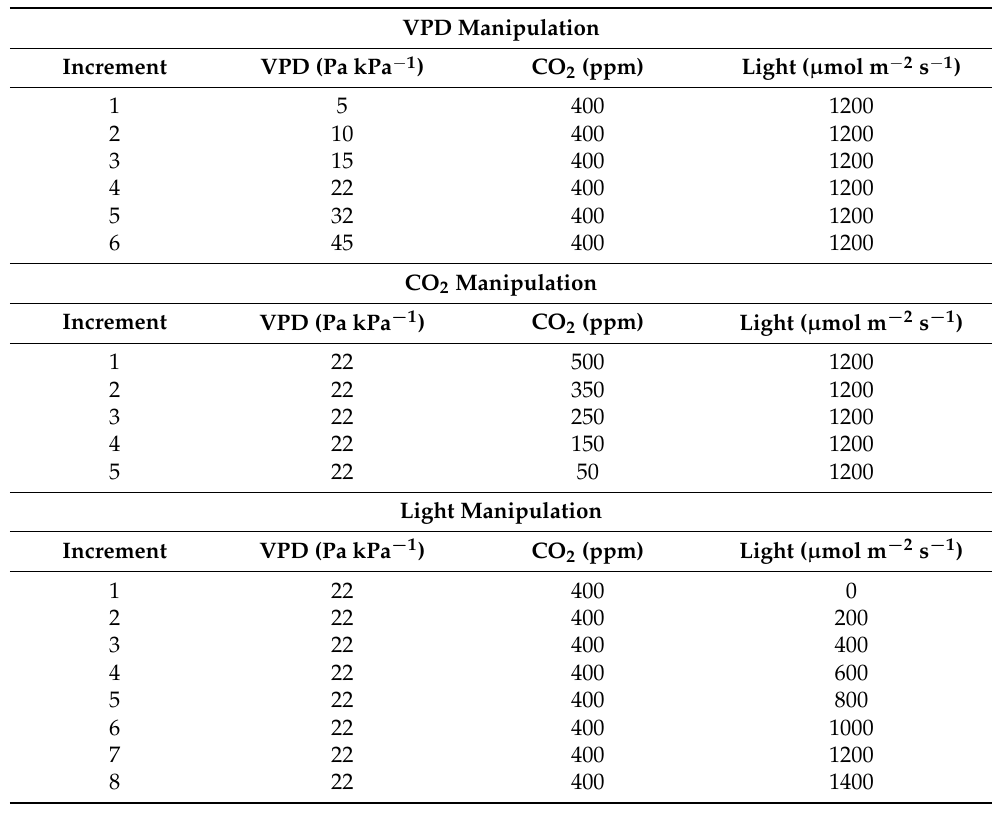
Table 1. Changing steps in vapor pressure deficit (VPD), CO 2 concentration, and light intensity, while the remaining two environmental parameters were kept